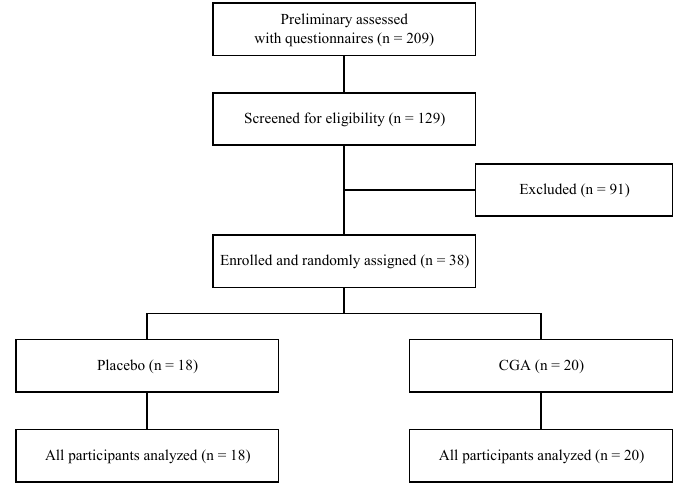
Figure 1. Flow diagram of the trial.